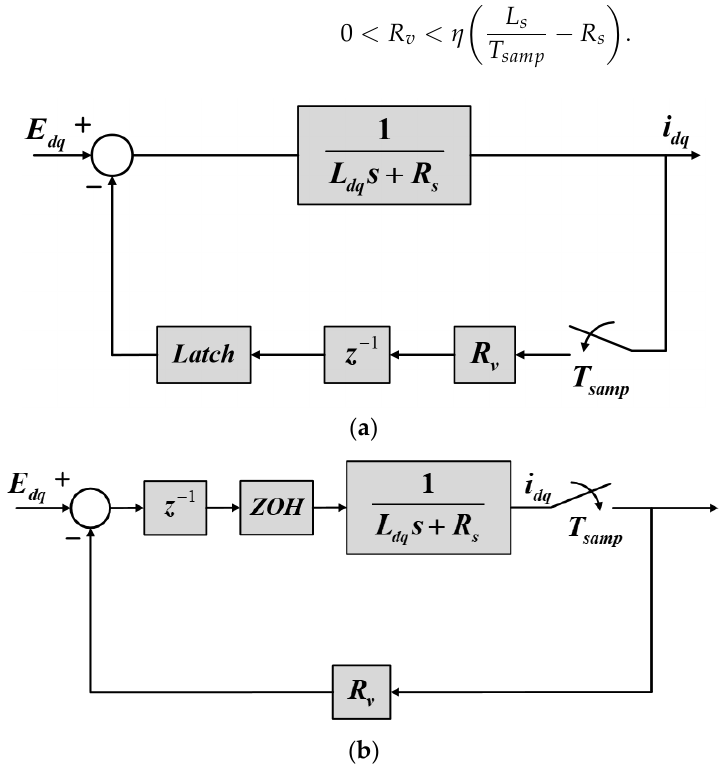
Figure 2. A d - q axis block diagram of the VR implementation based on the discrete inverter model. ( a ) An actual d - q axis model and ( b ) a simplified d - q axis model. The machine parameter varies according to the stator current, temperature, etc. There- fore, η has a value between 0 and 1 as a margin for parameter